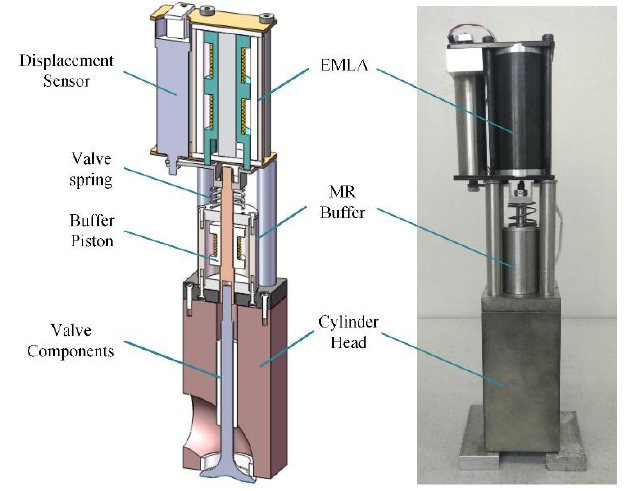
Figure 20. Valve seating test bench.